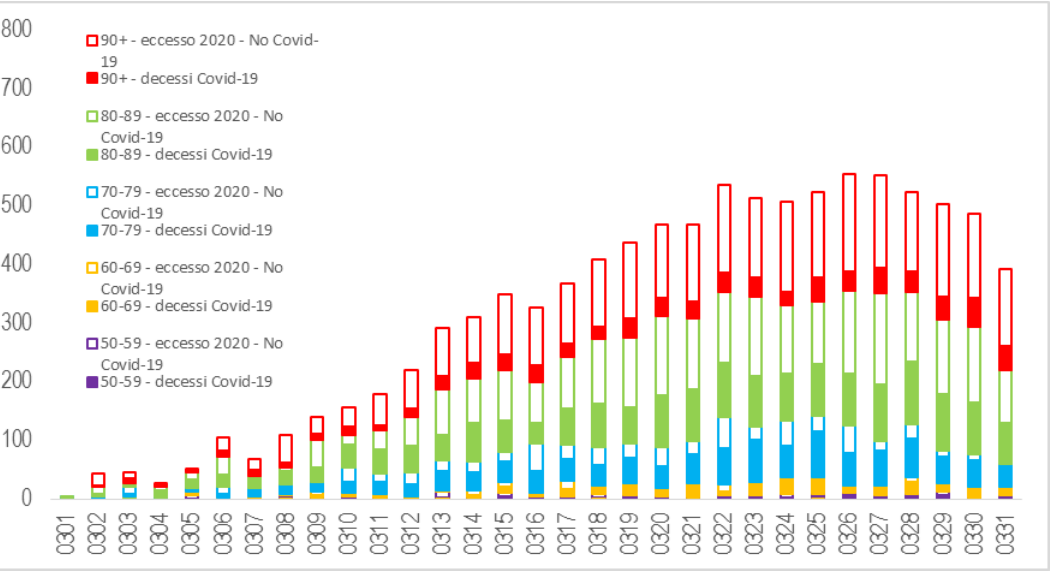
Figura 13. Andamento giornaliero nel mese di marzo della quota di mortalità femminile 2020 in eccesso rispetto alla media 2015-2019 coperta dai decessi Covid- 19 (a) . Valori assoluti per classe di età a partire dai 50 anni di età. Province con alto livello di diffusione